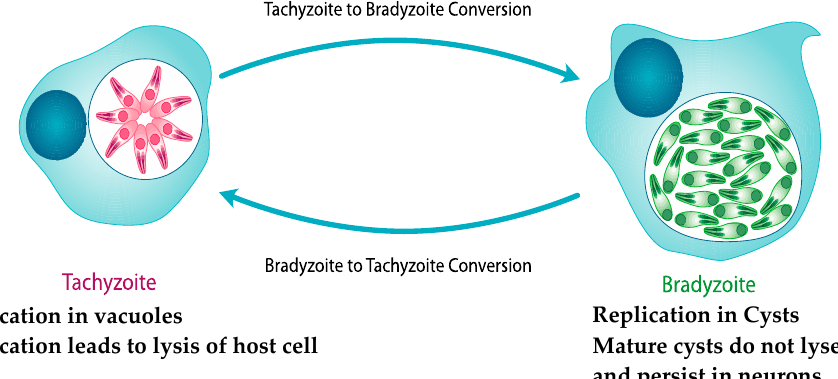
Figure 2. Parasite stages of T. gondii in host cells in the brain. The rapidly replicating tachyzoite stage replicates in vacuoles leading to lysis of the host cell usually within 36–72 h after infection of the host cell, and the slowly replicating bradyzoite stage replicates in cysts that do not lyse host cells and persist in neurons for the lifetime of the host.